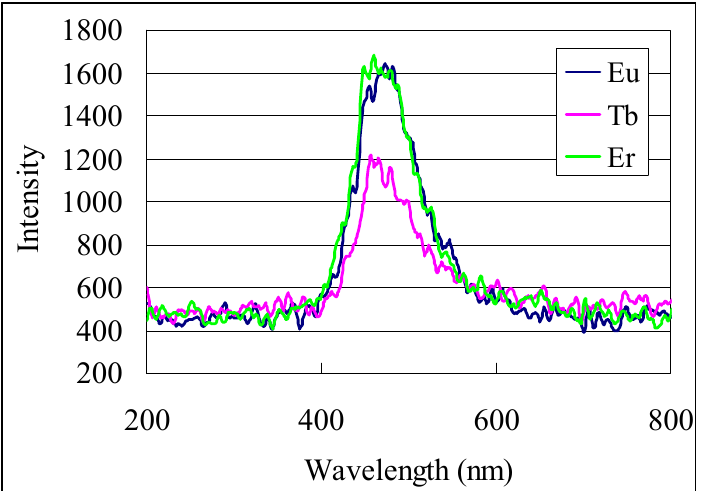
Figure 11. Cathode luminescence spectra of patterned metal oxides formed from pyrolysis of 1 -Eu, 1 -Tb and 1 -Er films at 500